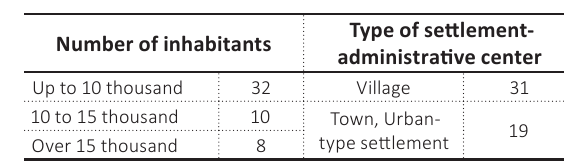
Table 1. Characteristics of territorial communities by population and by type of their administrative